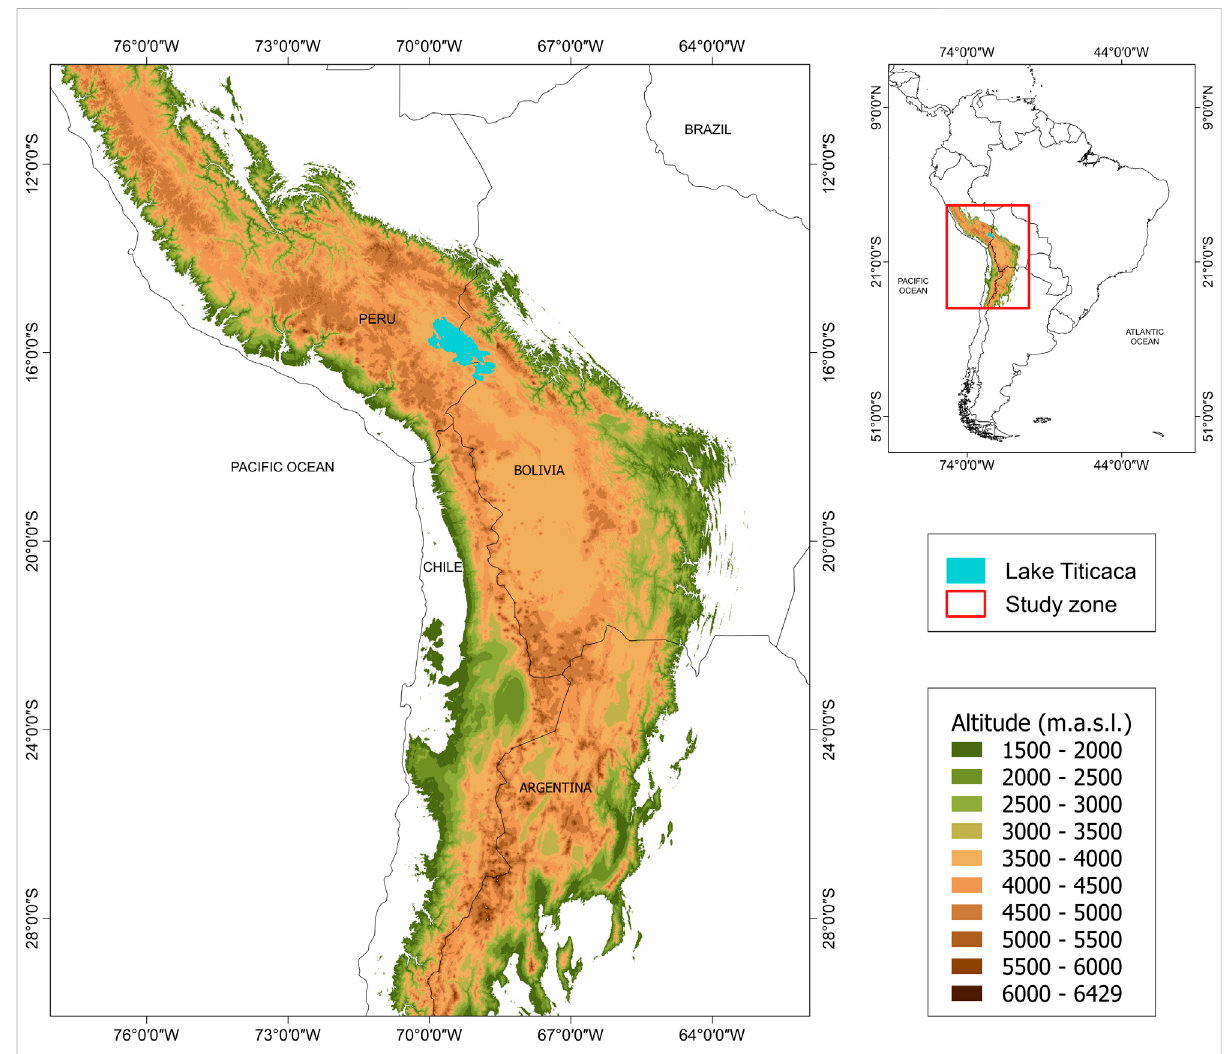
FIGURE 1 Location of the Central Andes. Shading indicates topographic elevation of the Andes mountains in m